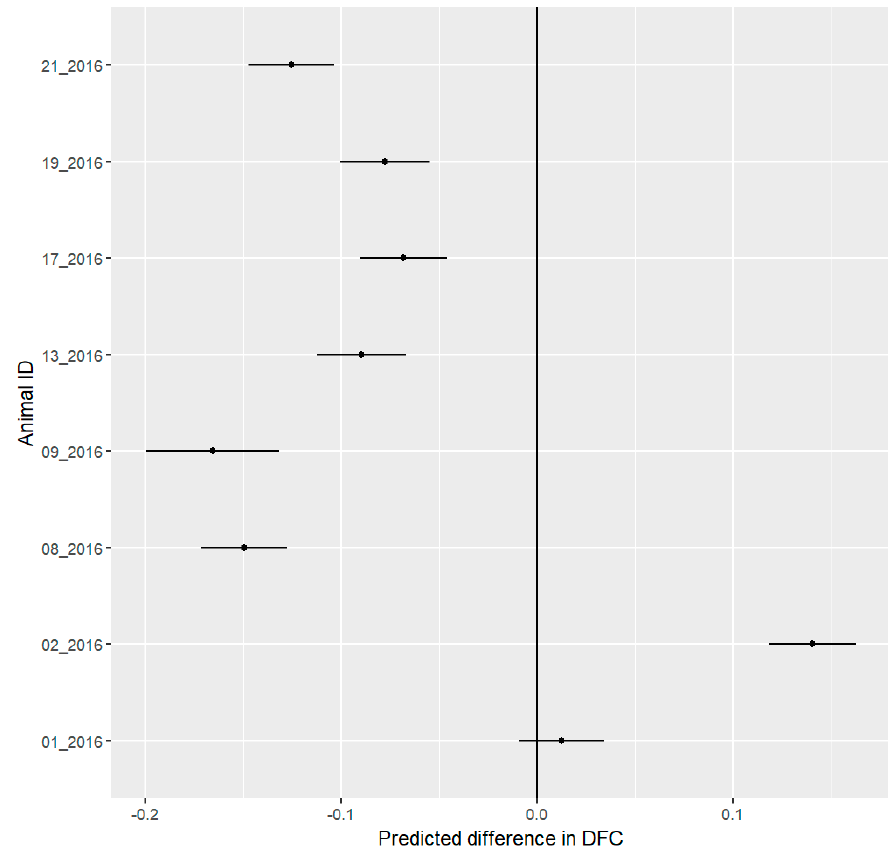
Figure 7. Mean predicted values with 95% confidence interval for differences in daily Degree of Functional Coupling (DFC) of eight hedgehogs between the pre-festival and festival phases. Negative values represent a decrease in the DFC during the festival, while positive values represent an increase during the festival. We consider all differences to be significant where the confidence interval does not include 0. Six out of eight individuals showed a significant decrease in the ODBA, while one other hedgehog showed a significant increase.